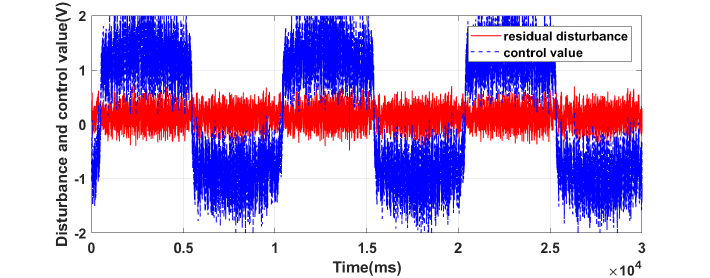
Figure 8. Residual disturbance